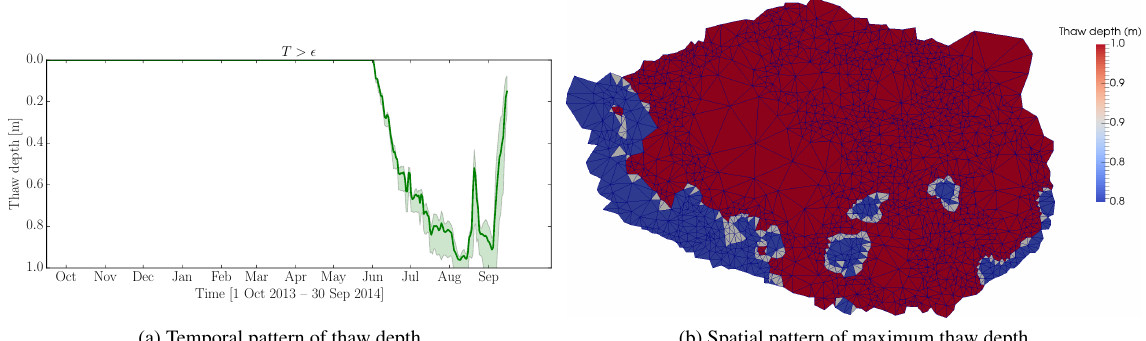
Figure 16. Temporal (left panels) patterns of simulated thaw depths (defined as thickness of soil layers above 0 ◦ C) and spatial pattern of maximum thaw depth (right panels) at Site D. The bold line represents the mean thaw depth across the site, while the shaded curve represents standard